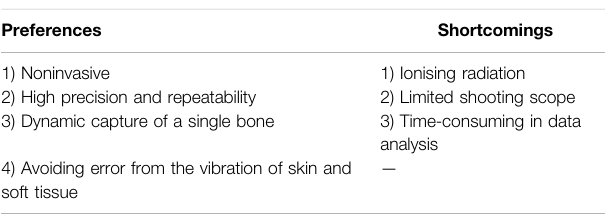
TABLE 4 | Preferences and shortcomings of the